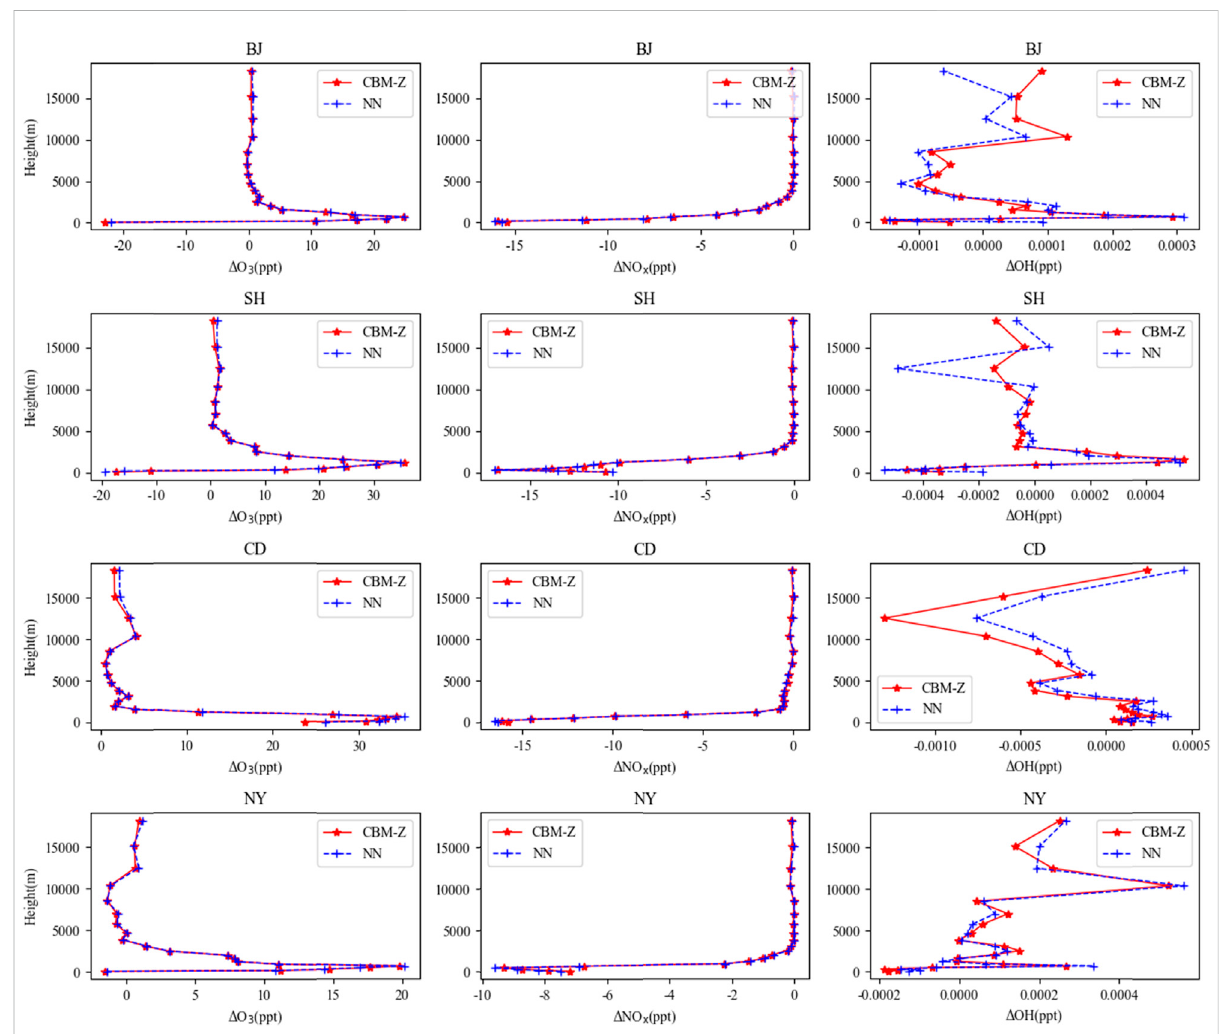
FIGURE 8 Vertical pro fi le of the 20-min daytime average concentration changes of O 3 , NO x , OH in the 8-h testing dataset predicted by CBM-Z module and neural network emulator in four cities (Bei Jing, BJ; Shang Hai, SH; Cheng Du, CD; New York, NY). The red broken line represents the simulated diurnal concentration change of CBM-Z module, and the blue broken line represents the simulated diurnal concentration change of the neural network